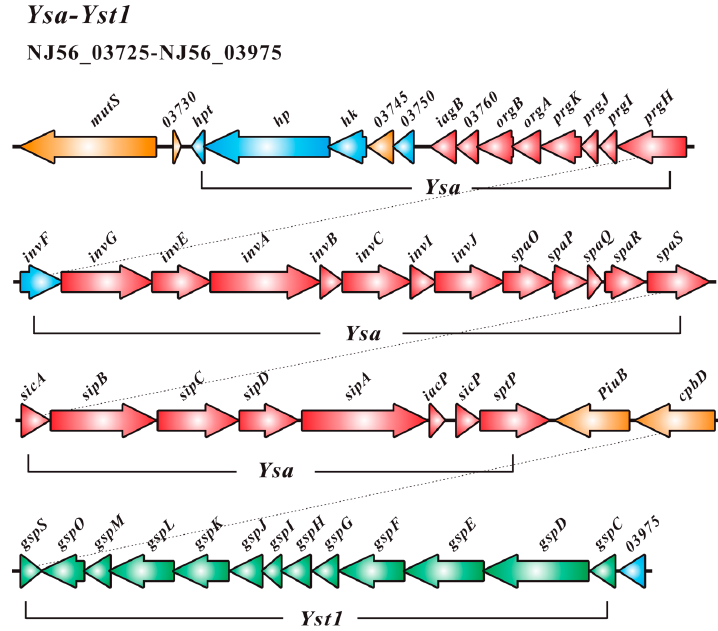
Figure 3. Gene clusters associated with type III secretion system Ysa and type II secretion system Yst1 in SC09.